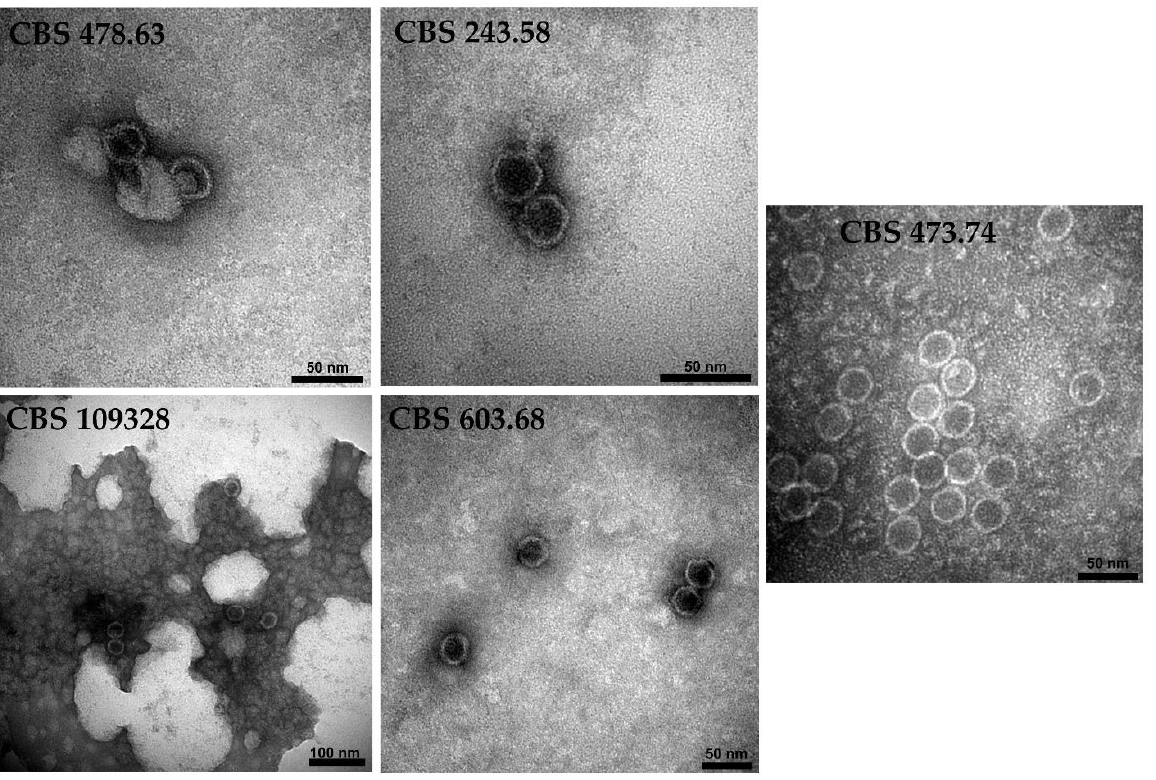
Figure 7. Virus-like particles detected in five mycovirus-harboring Umbelopsis strains. The virus